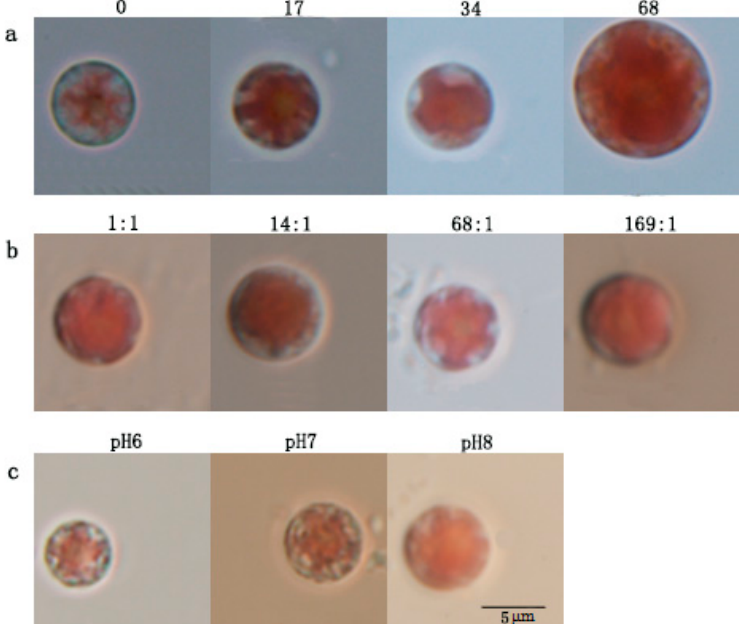
Figure 1. Cell morphology of P. purpureum under different conditions; the photos were taken under a 100 × optical microscope. ( a ). Cell morphology of P. purpureum at different salinities. ( b ). Cell morphology of P. purpureu m at different nitrogen-to-phosphorus ratios. ( c ). Cell morphology of P. purpureum at different pH conditions.